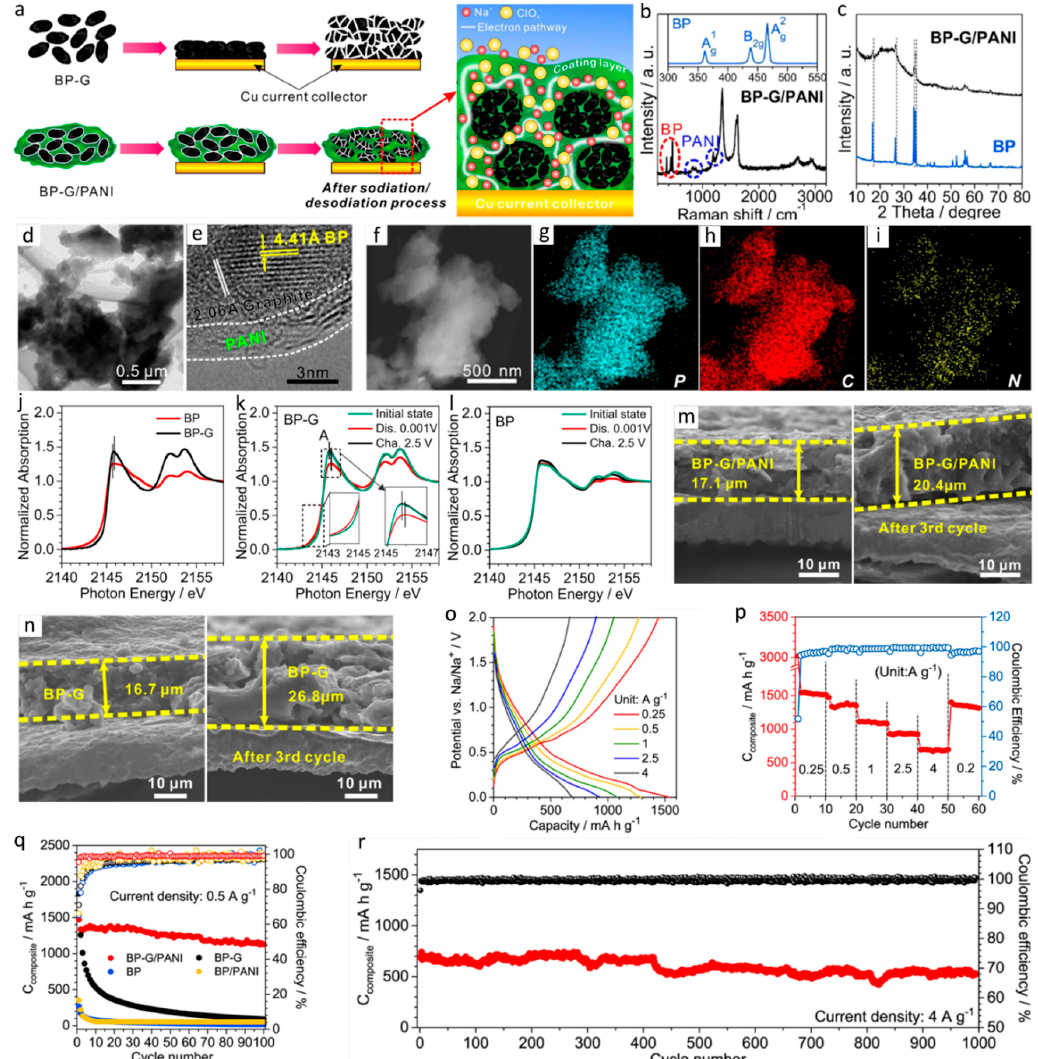
Figure 4. Structural characterization and electrochemical performance analysis of P-based anode (BP-G/PANI) in SIBs: ( a ) Schematic representation of sodiation process of black phosphorous-graphite (BP-G) and black phosphorous-graphite with polyaniline (BP-G/PANI). ( b ) Raman spectra shows the feature peaks of BP, graphite, and PANI. ( c ) XRD patterns show the characteristic diffraction peaks for BP at 2 ϴ values of 16.8, 26.5, 34.1, and 34.9 ֯ , a broad peak for PANI at ~22 ֯ . Raman spectra and XRD patterns confirm that BP particles remain intact in the BP-G/PANI composite. ( d ) TEM image and ( e ) HRTEM image of BP-G/PANI characterize the micro-structure. TEM and HRTEM image confirm that the BP particle are well coated with PANI. ( f–i ) TEM mappings of BP-G/PANI confirm the uniform distribution of P, C, and N in BP-G/PANI. ( j ) X-Ray absorption spectra of P state in BP and BP-G shows higher absorption edge in BP-G corresponding to higher charge transfer. ( k,l ) Ex situ XAS of P K-edge of BP-G and BP indicate the formation NA x P by sodiation in BP-G. ( m,n ) Cross-sectional SEM images of BP-G/PANI electrode and BP-G electrode show that PANI coatings attenuate the volume changes in electrode, providing a long cycling ability for BP-G/PANI. ( o ) The voltage profiles of BP-G/PANI at different current densities in the potential range: (0.01–2.00 V). The capacity loss in the first cycle is attributed to the SEI film formation. ( p ) Rate capability test of BP-G/PANI anode shows that it can deliver 690 mAh g − 1 (45% capacity retention) at high current rate of 4 A g − 1 . ( q ) The cycling stability and coulombic efficiency of BP, BP-G, BP-G/PANI at 0.5 A g − 1 show that the reversible capacity of BP-G/PANI is mostly contributed by BP. ( r ) The cycling ability and coulombic efficiency of BP-G/PANI anode at 4 A g − 1 show that it can deliver a reversible capacity 520 mAh g − 1 after 1000 cycles. Reprinted with permission from [92] . Copyright 2019 American Chemical Society.